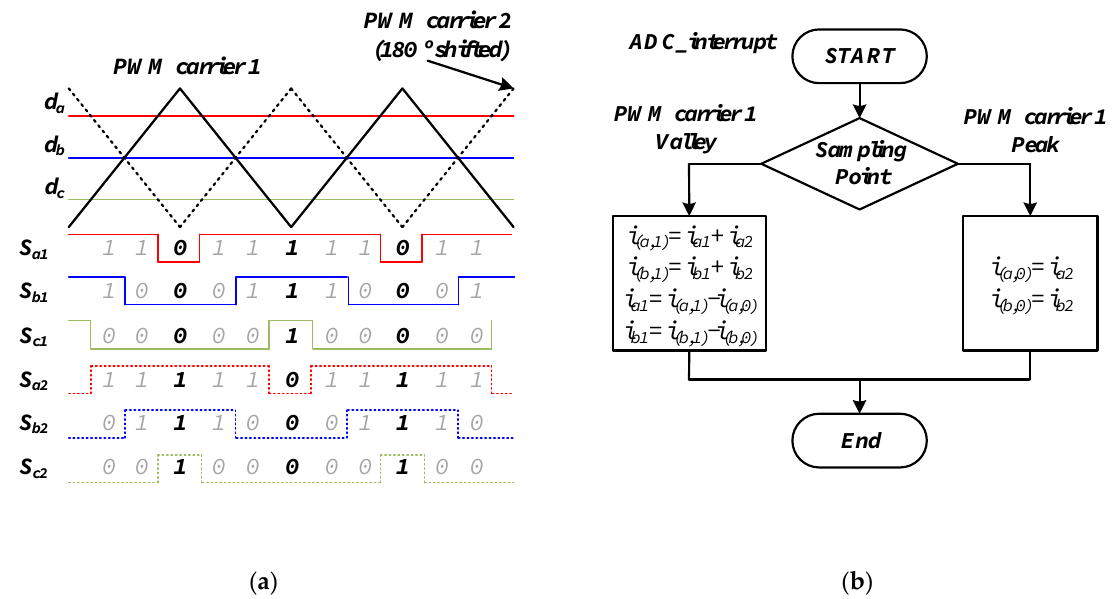
Figure 3. Sampling point and proposed current reconstruction method. ( a ) Sampling points with PWM carriers. ( b ) Current reconstruction algorithm.